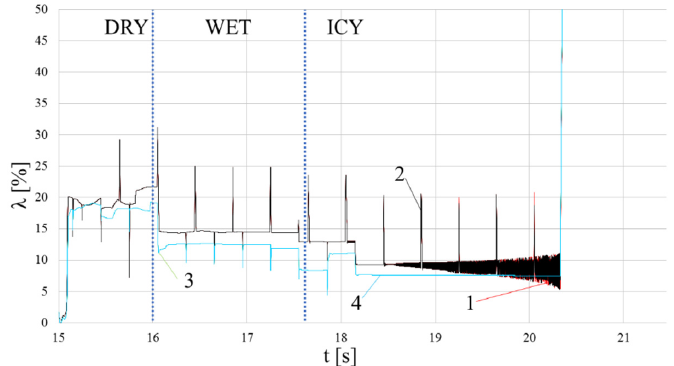
Figure 13. Braking on a straight road with dry–wet–icy surfaces profile slip curves: 1—FL wheel slip, 2—FR wheel slip, 3—RL wheel slip, 4—RR wheel slip.